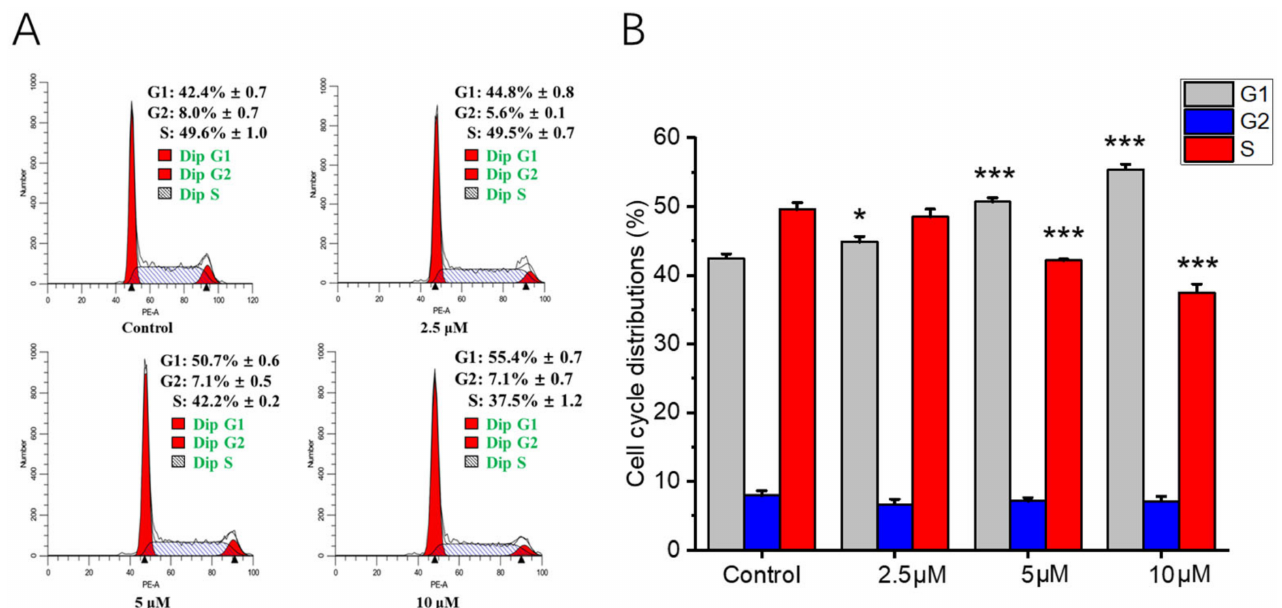
Figure 2. Arrest effects of compound 1b on cell cycle distribution in A549 cells. A549 cells were treated with 2.5, 5, and 10 µ M of compound 1b for 48 h. DMSO was used as a negative control. (A ) The cell cycle ratio of A549 cells was detected using a cell cycle staining kit, and the cell cycle distribution was analyzed using flow cytometry. ( B) Related histogram of cell cycle phases distribution, expressed as the mean ± SD ( n = 3). * p < 0.05, *** p < 0.001 vs. the control